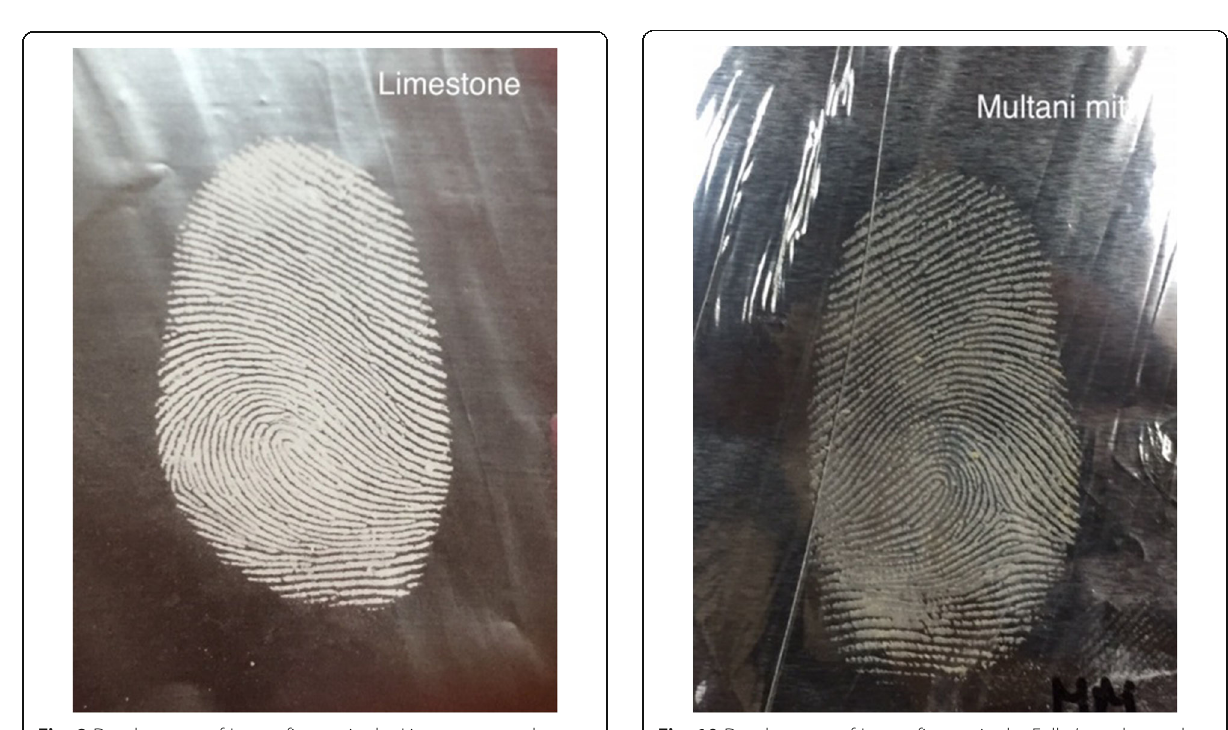
Fig. 8 Development of Latent fingerprint by Limestone powder on Aluminum Foil